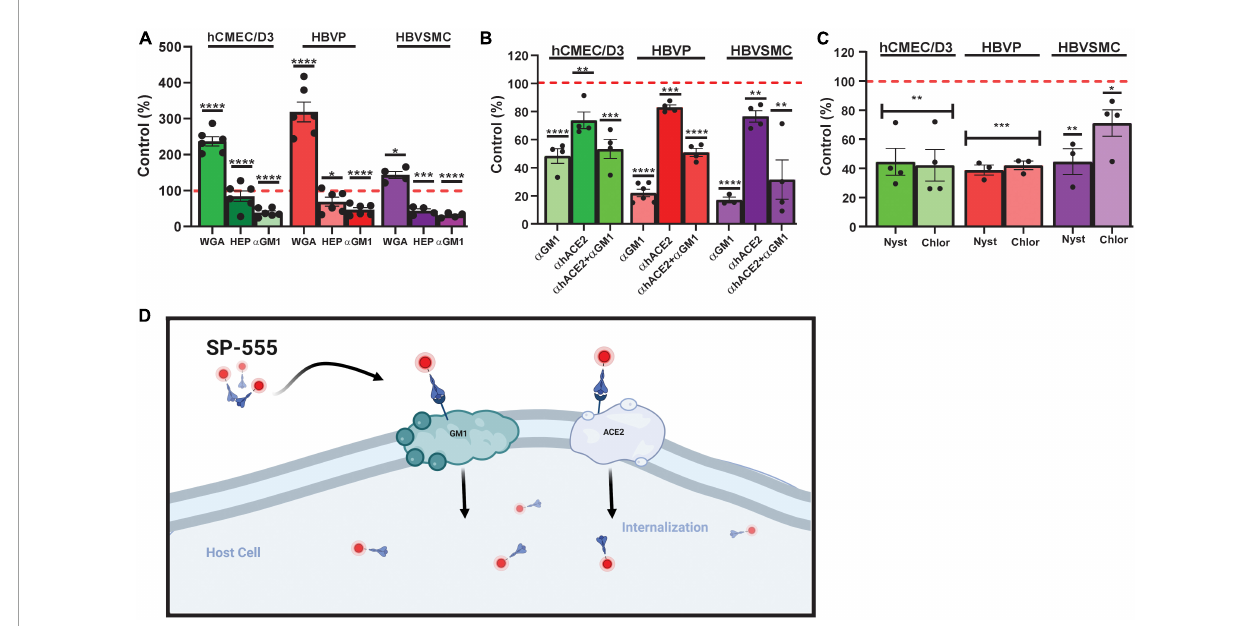
FIGURE4 Sialic acid-/GM1-mediated SP uptake by cerebrovascular cells. (A) Effect of wheat germ agglutinin (WGA), heparin (HEP) and anti-mono-sialotetra- hexasylganglioside antibody ( α GM1) on SP-555 uptake. (B) Effect of α GM1, anti-human ACE2 antibody ( α ACE2) and both α GM1 and α ACE2 together on SP-555 uptake. (C) Effect of nystatin and chlorpromazine on SP-555 uptake. Controls were SP-555 intensities in the absence of the test compounds. (D) Schematic diagram showing a proposed SARS-CoV-2/SP uptake by both GM1 and ACE2. Both GM1 and ACE2 are present within the lipid raft region of cell membranes. Created by using BioRender.com. Red dashed line is the control levels (100%). Values are mean ± SEM. N = each data point is a well. Supplementary Figure 4 . Statistically analyzed was by analysis of variance (ANOVA) followed by Tukey post-hoc test. * P < 0.05, ** P < 0.01, and *** P < 0.001 and **** P < 0.0001. GraphPad Prism version 9.2.0 was